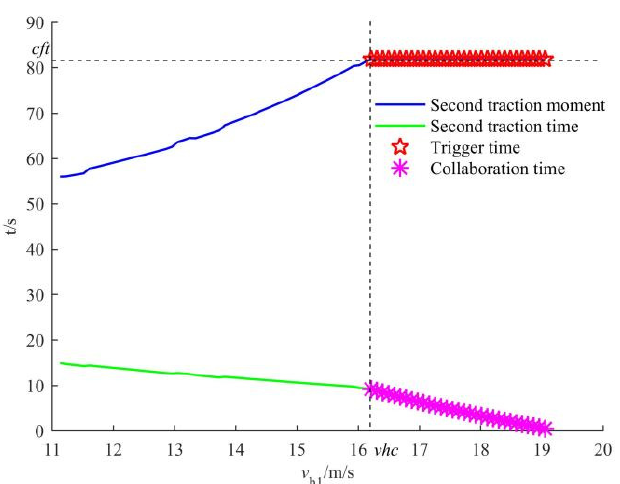
Figure 2. Change trend of trigger time and coordination time with v h1 .